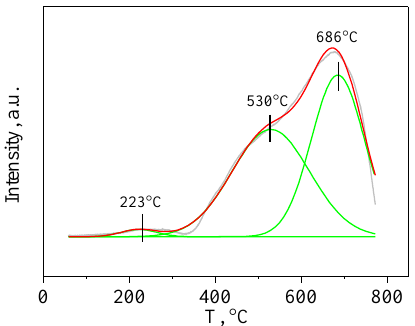
Figure 2. H 2 -temperature programmed reduction (H 2 -TPR) profile of the catalyst after calcination and the peak split results.